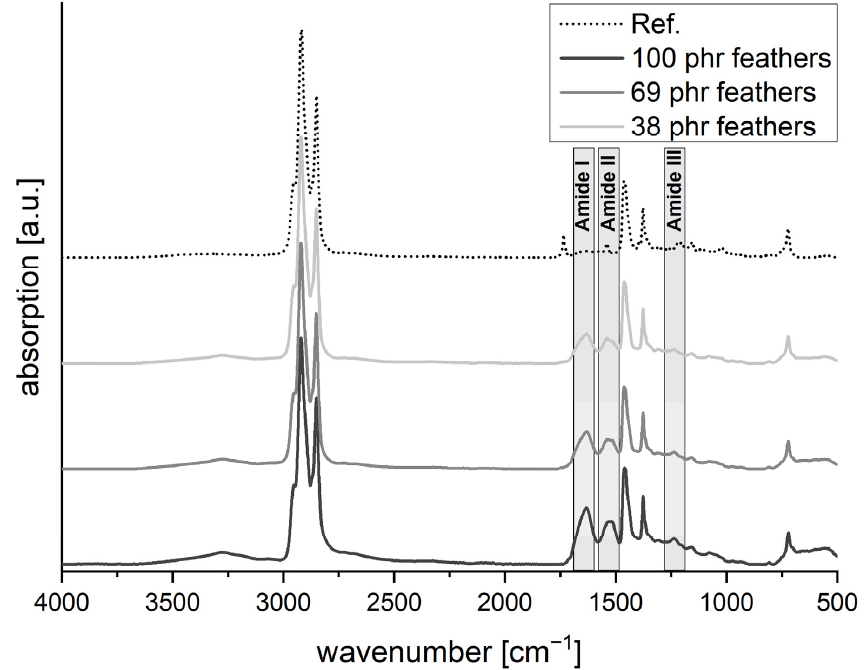
Figure 5. Attenuated total reflection–Fourier transform infrared spectroscopy (ATR-FTIR) analysis of vulcanised EPDM (M1) filled with increasing amounts of 0.08 mm feathers. A vulcanised M1 mixture without feathers is used as reference.